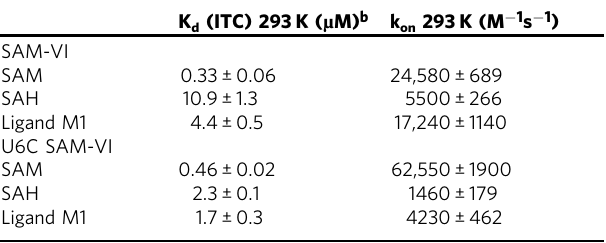
Table 1 Thermodynamic and kinetic parameters of ligand binding to SAM-VI a